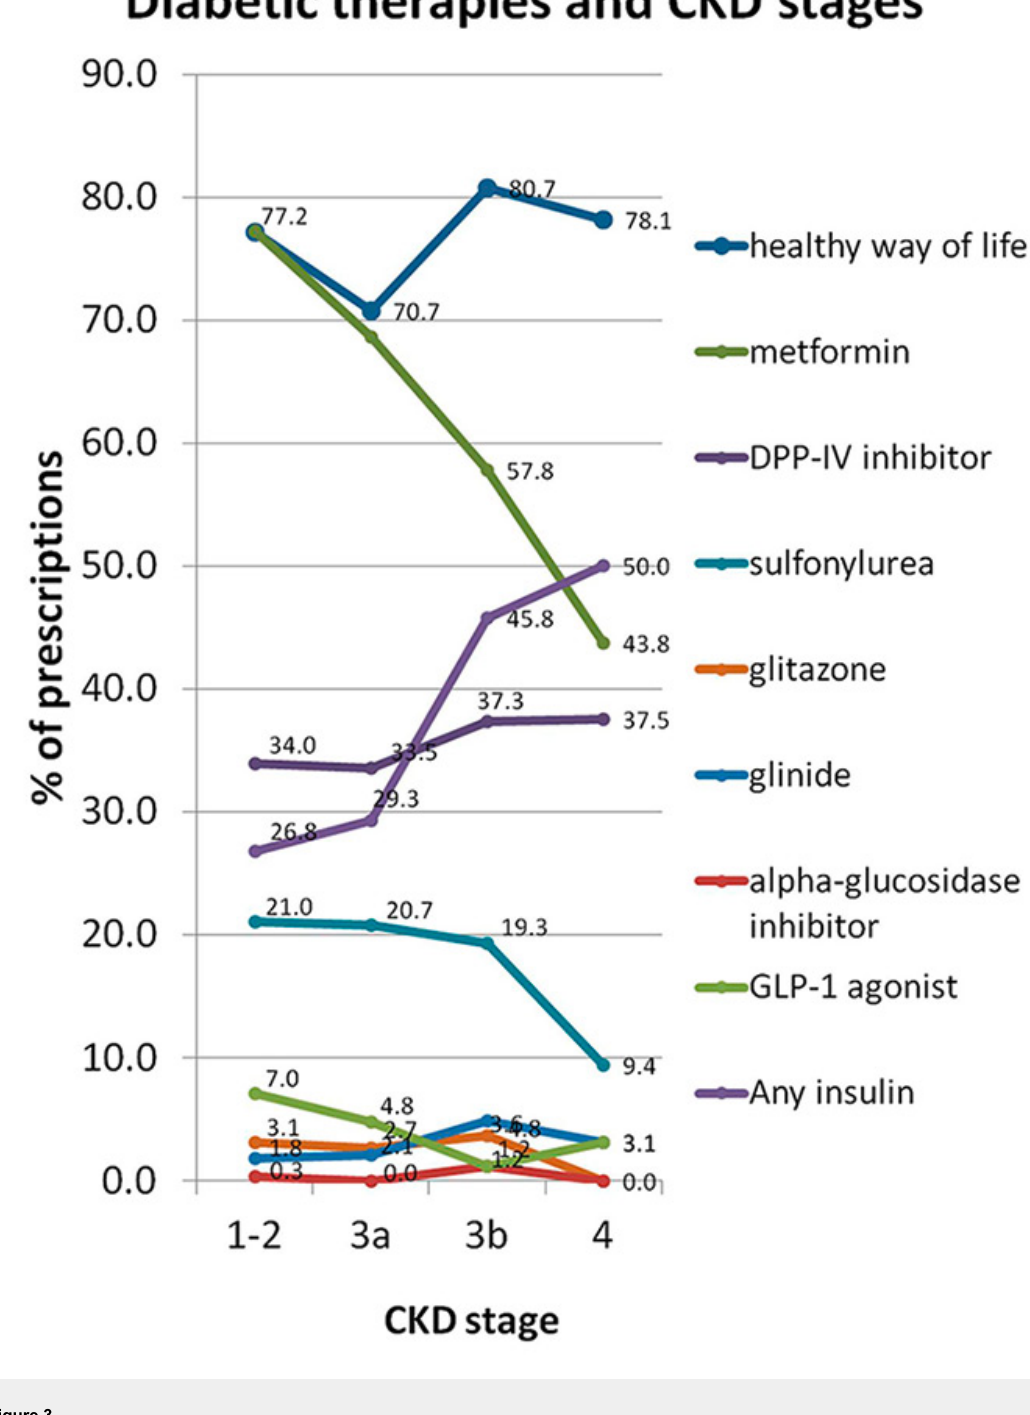
Figure 3 Antidiabetic class prescriptions (%) and chronic kidney disease (CKD) stage. DPP-IV = dipeptidyl-peptidase-4; GLP-1 = glucagon-like